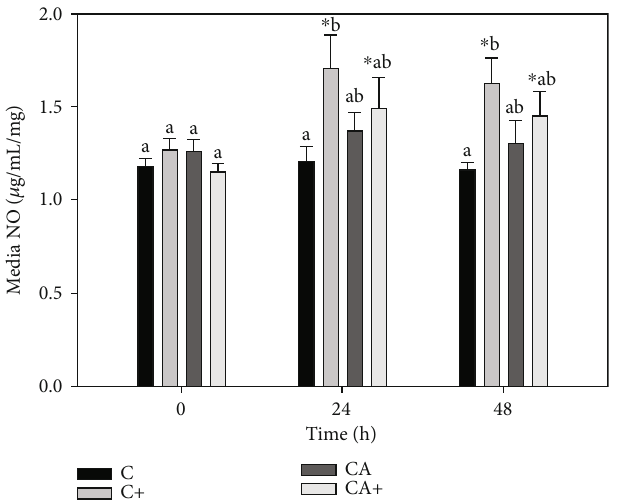
Figure 5: Nitric oxide (NO) production by cartilage explants (C) cultured in the presence or absence of adipose tissue explants (A) and/or LPS (+; 10 μ g/mL). Data represent duplicate samples from 16 market-weight pigs. ∗ Denotes signi fi cant change from 0 h within a single treatment group. Lowercase letters denote signi fi cantly di ff erent means at a single time point ( p < 0 : 05